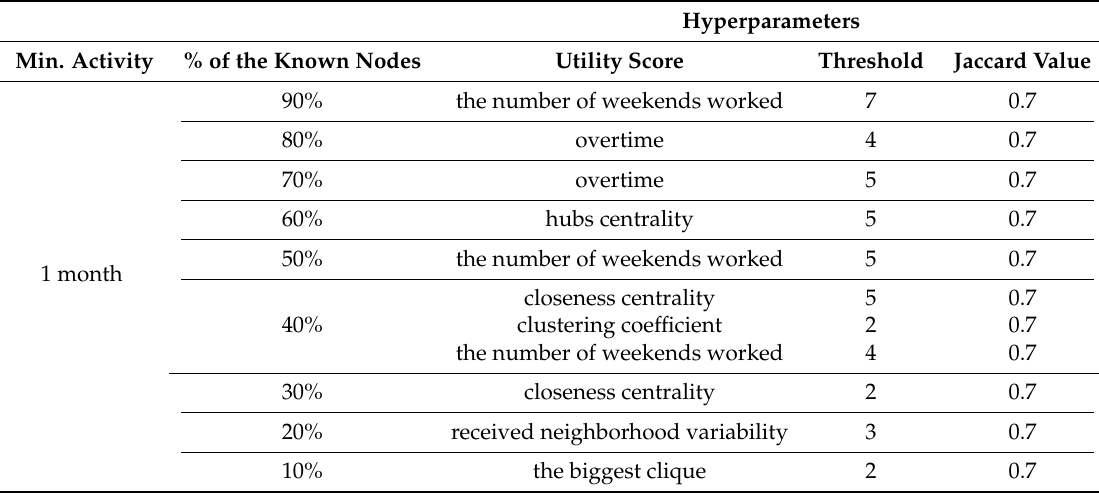
Table A29. The best values of the hyperparameters for the collective classification algorithm for the manufacturing company dataset with three hierarchy